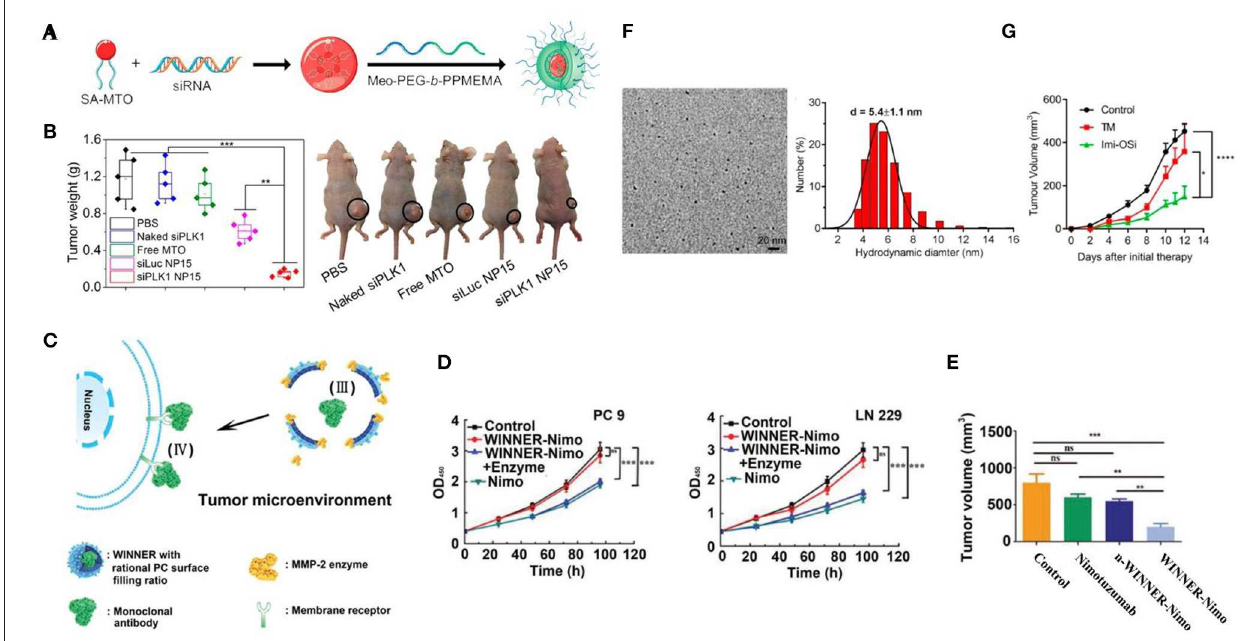
FIGURE 1 | Bioresponsive nanomedicine for lung, breast, and prostate cancer therapy. (A) Scheme of synthesis of SA-MTO (NP15); (B) MDA-MB-231 tumor weights from nude mice xenograft model that were treated with different groups and representative photograph tumor-bearing mice at day 18 [(Saw et al., 2019) #157] (Copyright 2019, reproduced with permission from American Chemical Society). (C) Schematic illustration of WINNER coating with PC ratio for extracellular delivery of mAb; (D) The antitumor efficacy of WINNER-Nimo in LN 229 and PC 9 cells; (E) Tumor volume from different treatment groups [(Li et al., 2019) #178] (Copyright 2019, reproduced with permission from Wiley). (F) TEM image and DLS of Imi-OSi; (G) 4T1 tumor inhibition efficiency of TM (copper chelator) and Imi-OSi (Yang et al., 2019b #182) (Copyright 2019, reproduced with permission from American Chemical